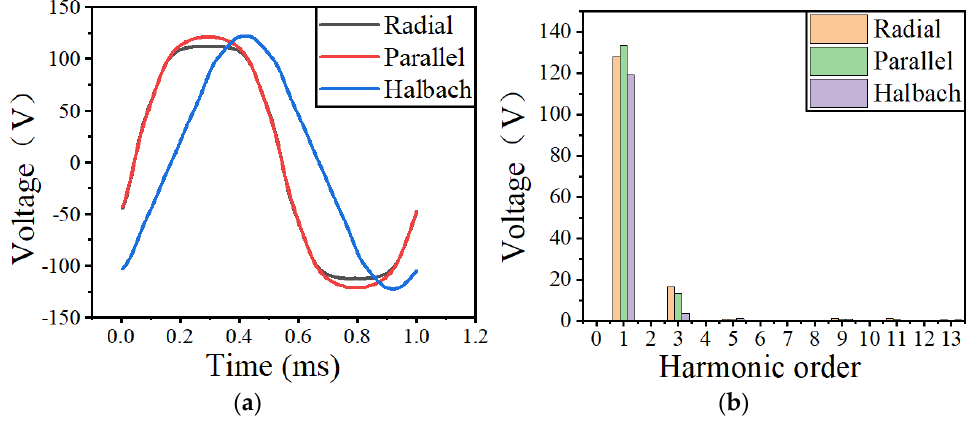
Figure 9. Waveforms and FFT analysis results of back EMF for HSPMMs with different magnetization methods. ( a ) Waveforms; ( b ) FFT analysis results.